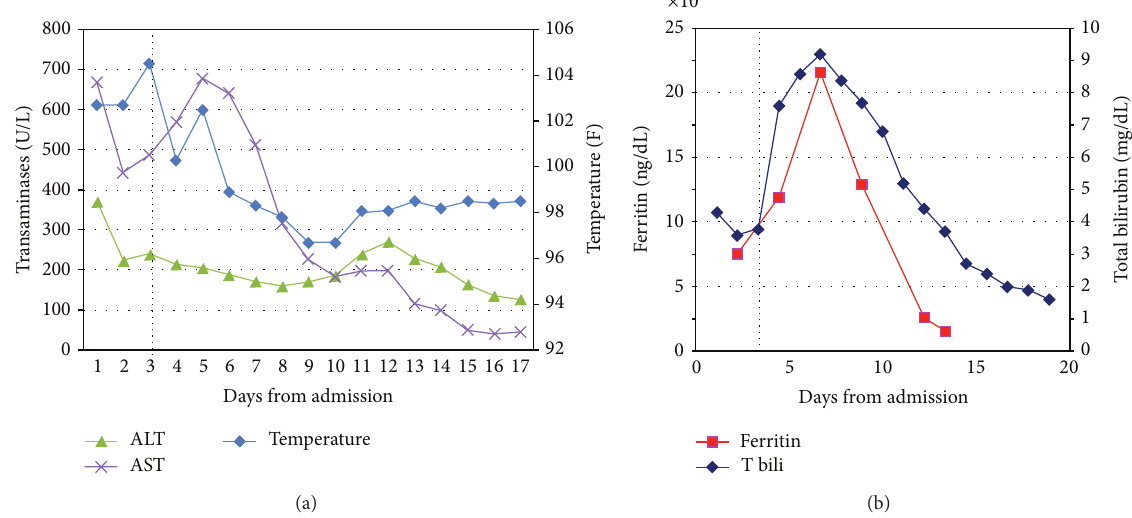
Figure 2: Trend of liver enzymes, temperature (a), total bilirubin, and ferritin (b) during the initial hospital stay. Dotted line indicates the start of therapy on day 3 (ALT: alanine aminotransferase; AST: aspartate aminotransferase; T bili: total bilirubin).